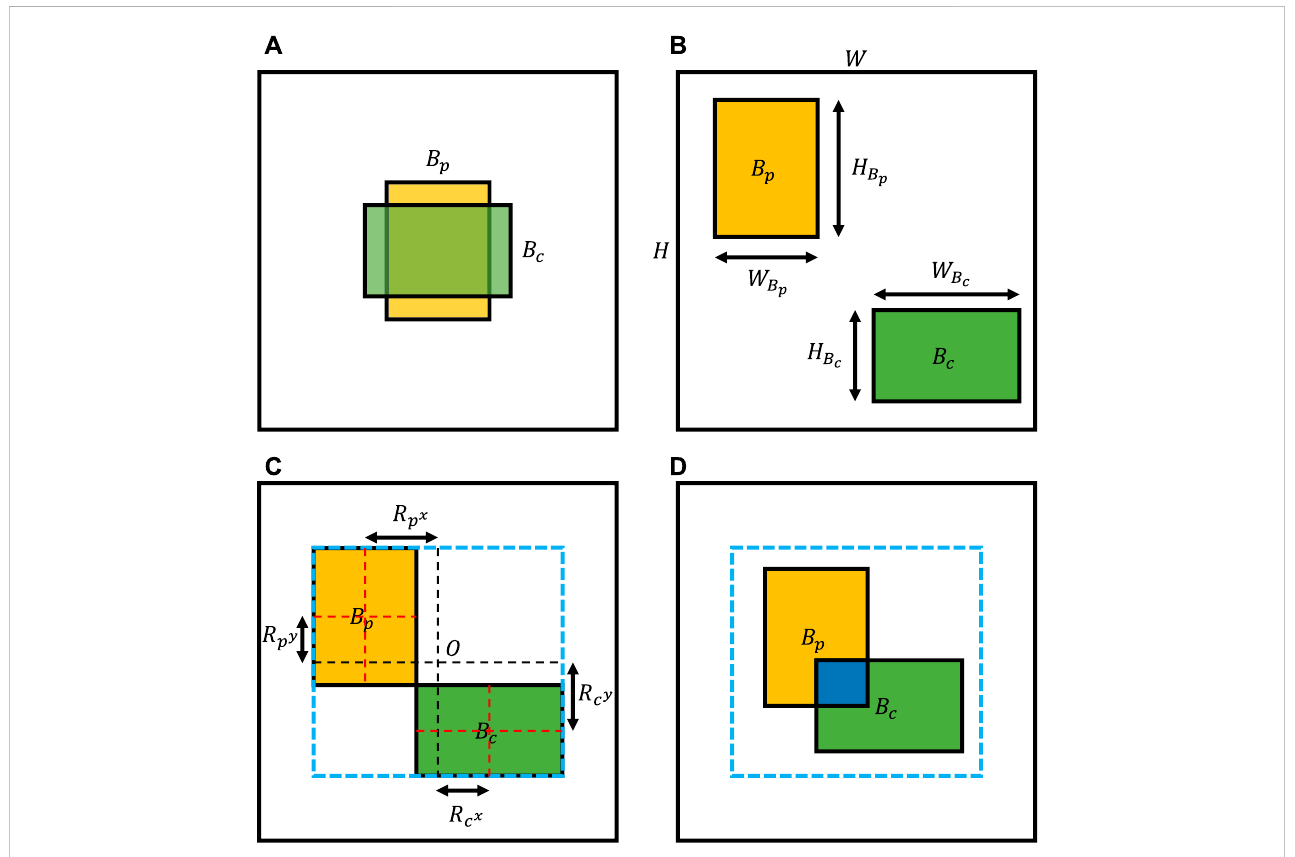
FIGURE 3 Illustration of image shift. (A) Common composing image without image shift. (B) Invalid composing image because we do not limit image shift ranges. (C) The image shift range determined by the maximum outer enclosing box of two bounding boxes. (D) Valid composing result, as we sample image shifts under a reasonable range.